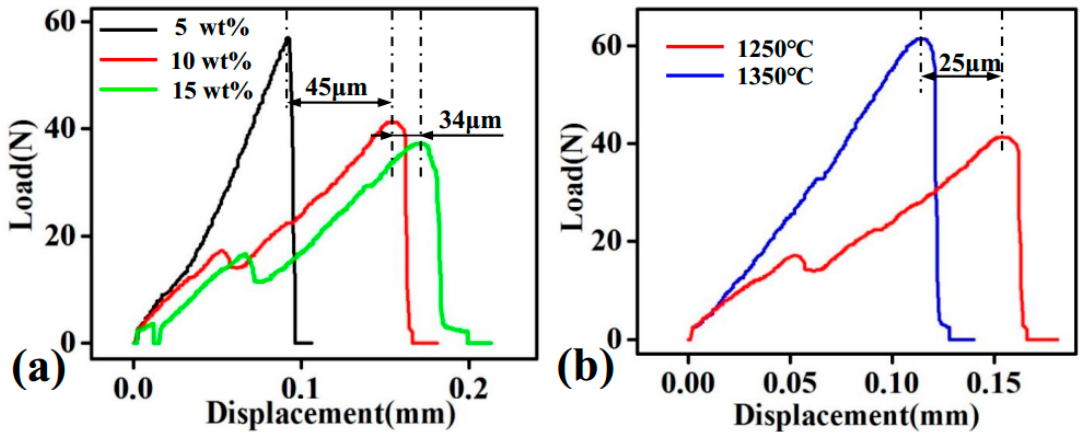
Figure 9. Load versus displacement plot of the composites: ( a ) sintering at 1250 ◦ C with 5 wt %, 10 wt %, and 15 wt % MF addition; ( b ) sintering at 1250 ◦ C and 1350 ◦ C with 10 wt % MF addition.